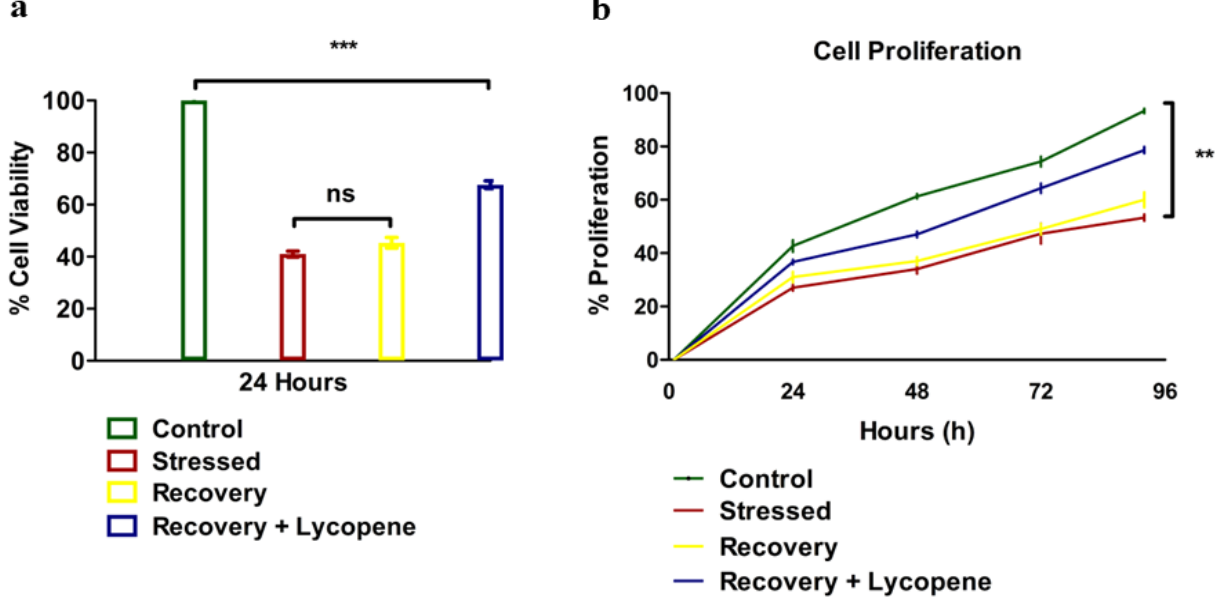
Figure 1. ( a ) Cell viability of HUVSMCs (n = 3, ( p < 0.0145)). ( b ) Cell Proliferation of HUVSMCs during stress, recovery and recovery + Lycopene (n = 3, ( p < 0.0001)). All the tests were repeated at-least three times at different time points for consistency. (** p < 0.01, *** p < 0.001). Secondly, the diminished cell viability and slow recovery of the SMCs to normal phe- notype was assessed for autophagy by transmission electron microscopy (TEM). The cells which were under stress (Figure 2b,e) showed enhanced number of autophagic vacuoles (~15%) compared to the control (Figure 2a) while the recovery by lycopene + recovery media (Figure 2d,e) was significantly lower (~5%) than the recovery (Figure 2c,e) by plain media which showed (~8%) ( p < 0.0158). The induction of autophagy and subsequent recovery by lycopene was confirmed by mRNA expression of the autophagic markers LC3A ( p < 0.0187) and B ( p < 0.0242) (Figure 2f) which very well correlated with the TEM autophagy (Figure 2a–e).